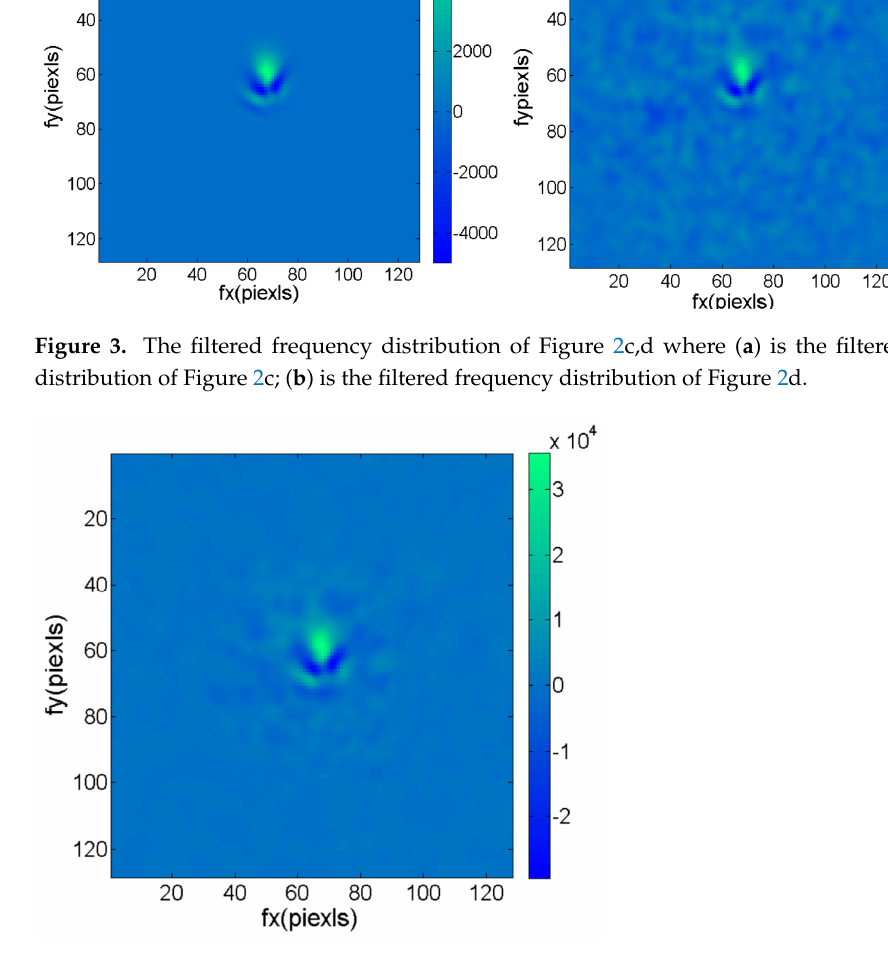
Figure 4. The superposition of the frequency distribution in the region of (182–186, 63–67), namely, a square area with the center at coordinate (184, 65) and the side of 4